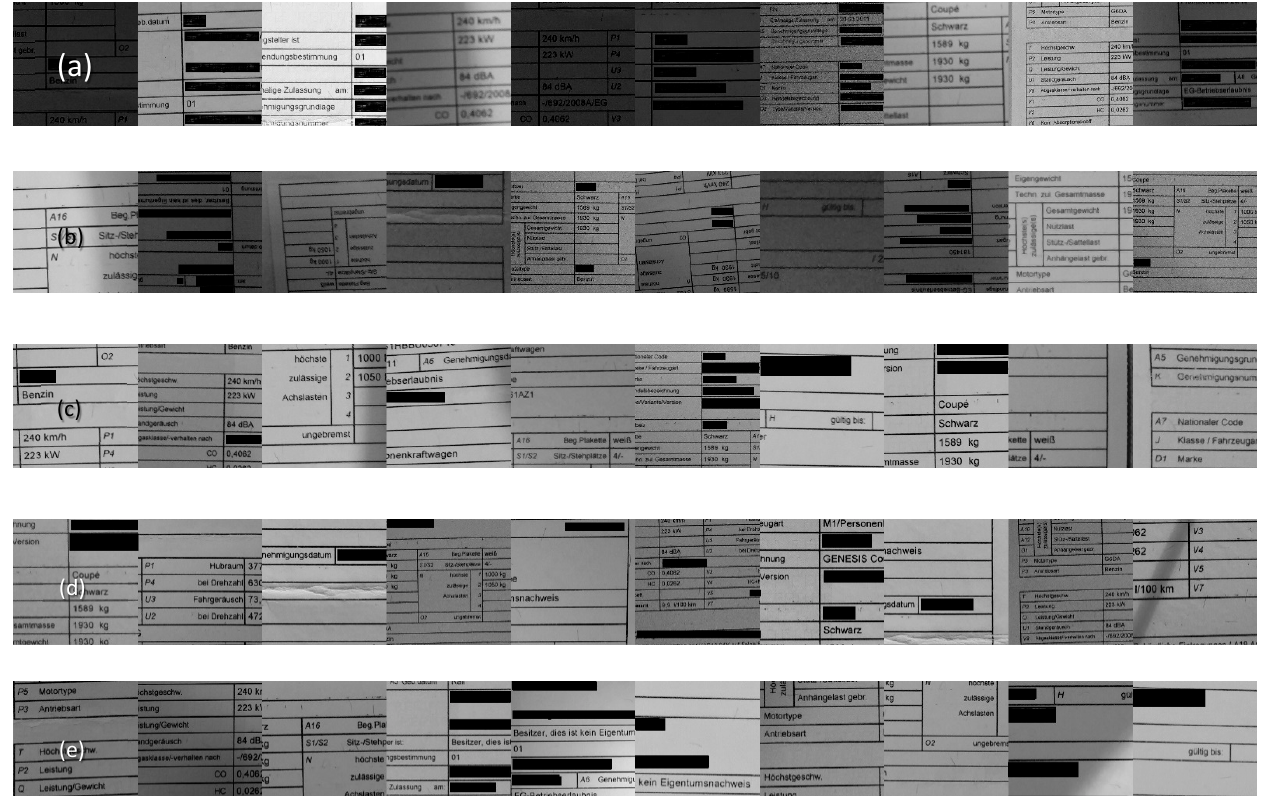
Figure 11. Different image qualities which were extracted from our own made dataset. Image ( a ) shows very bad-quality samples. Image ( b ) shows bad-quality samples. Image ( c ) shows average- quality samples. Image ( d ) shows good-quality samples. Image ( e ) shows very-good-quality